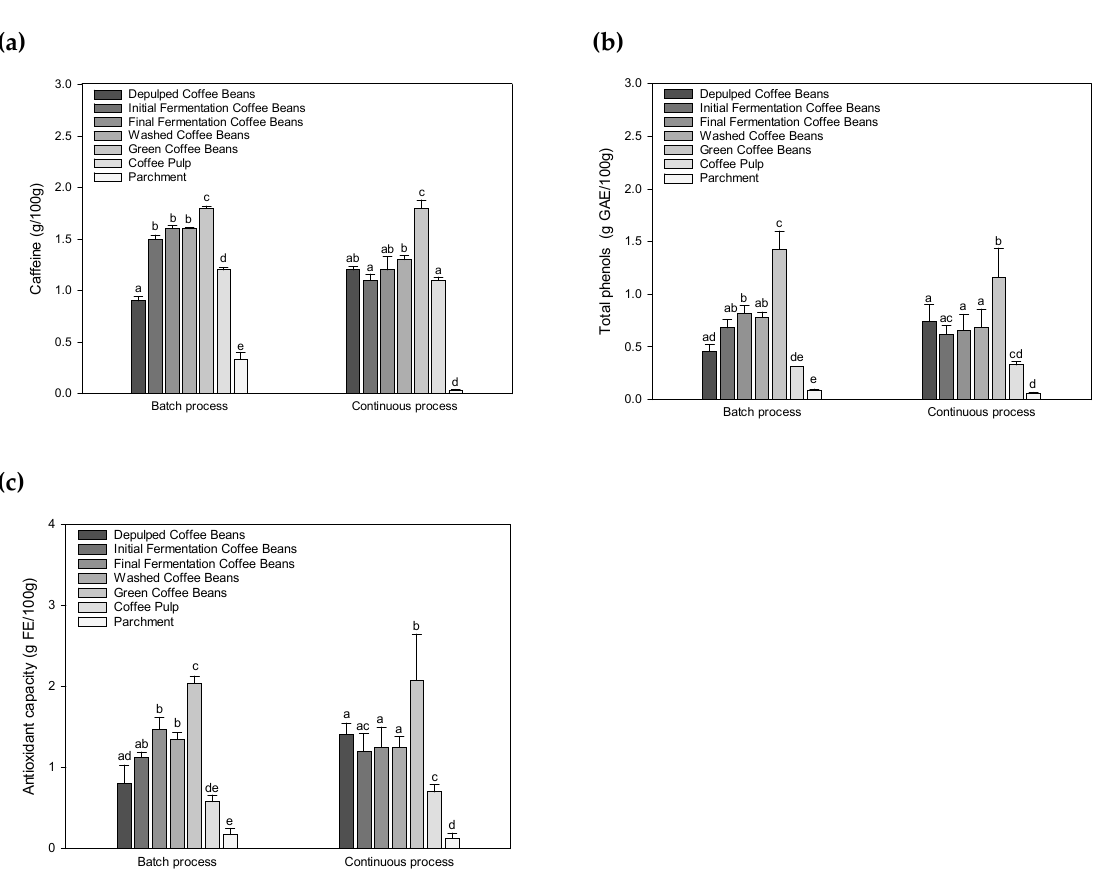
Figure 2. Content of ( a ) caffeine, ( b ) total phenols and ( c ) antioxidant capacity of coffee beans and by-products during the wet batch and continuous processing. The antioxidant capacity is in Ferric Reducing Ability of Plasma (FRAP) equivalents (FE). Data are expressed as means ± standard deviation n = 3. Different letters indicate significantly different values for each group (different superscript letters indicate a significant different, p < 0.05, ANOVA, Tukey’s test).